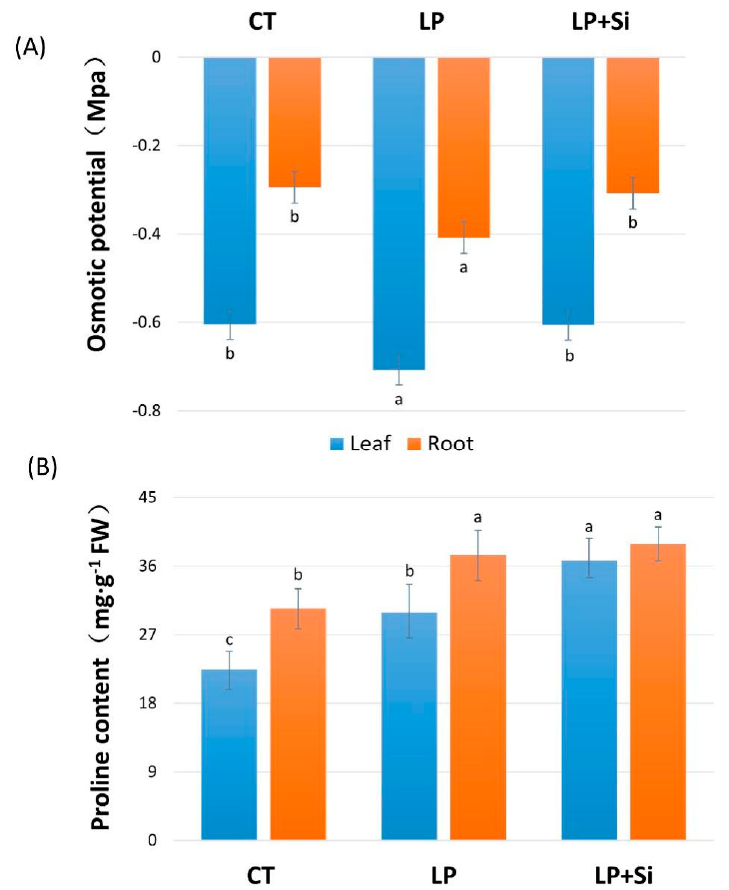
Figure 3. E ff ect of low phosphorus (LP) and silicon (Si) on osmotic potential and proline content in tomato plants: ( A ) Osmotic potential and ( B ) proline content in tomato leaves and roots. Data are shown as means ± standard deviation (SD) of three replicates. Bars with the same color but di ff erent letters indicate statistically significant di ff erences at p ≤ 0.05.